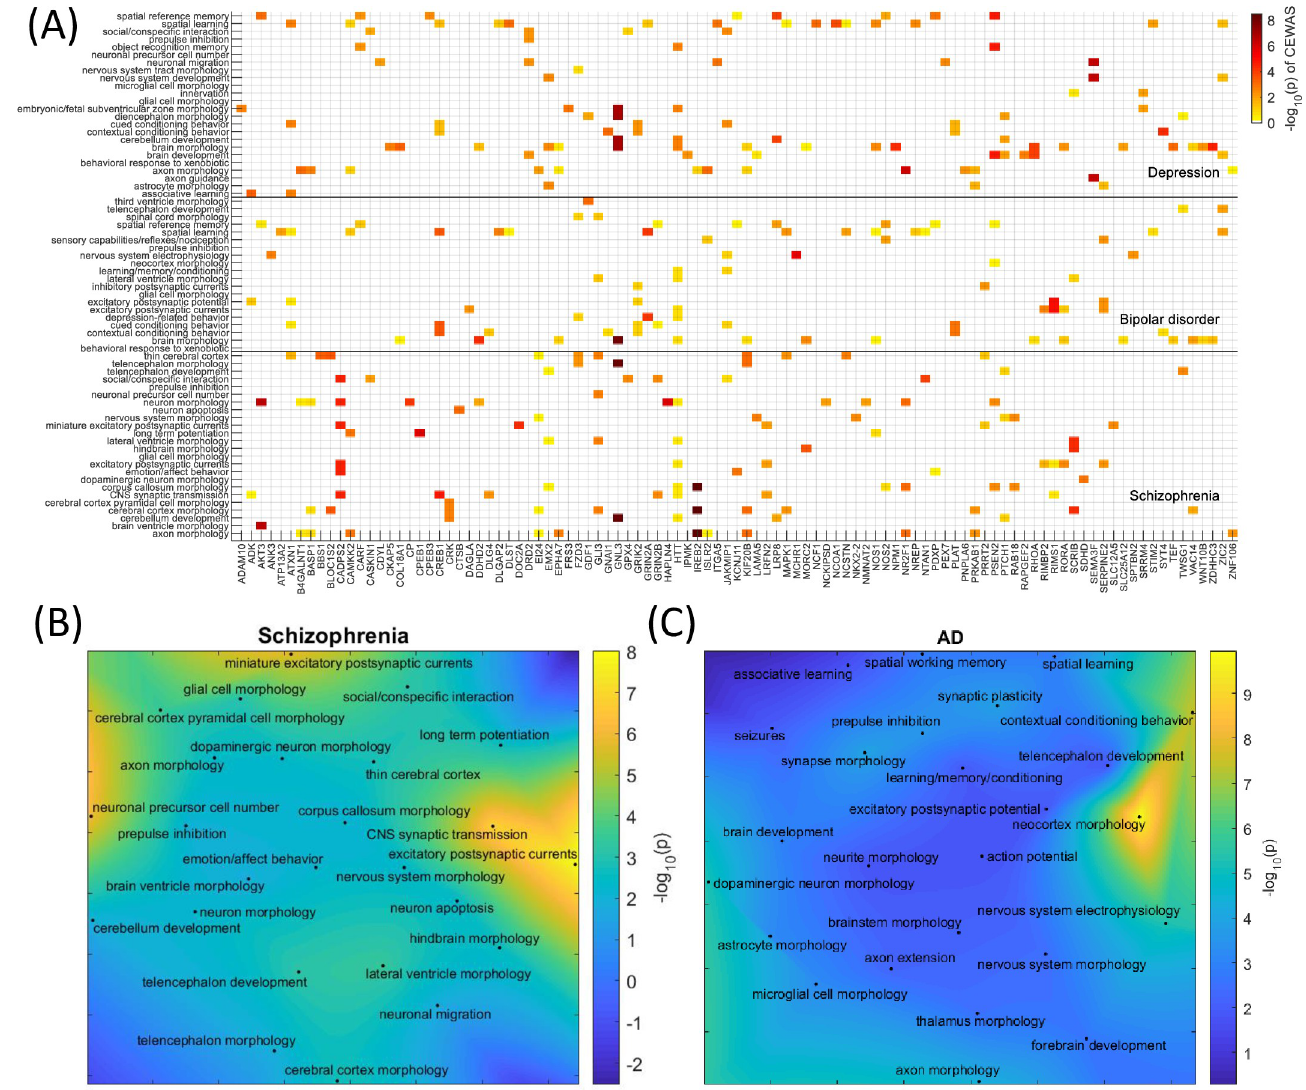
Fig 5. Gene set enrichment. (A) Top CNS gene sets enriched for schizophrenia, bipolar disorder, and depression as found by CEWAS displayed against genes belonging to at least one of these enriched gene sets and have CEWAS p < 0.05 in at least one of the three psychiatric disorders. The color reflects the level of association between a given gene and a disorder. For each gene set, only genes belonging to that gene set have their–log 10 (p) displayed, with the rest of the genes masked to zero. (B) Top 25 CNS gene sets enriched for schizophrenia as found by CEWAS displayed. The binary representation of the gene sets are projected onto 2D space using UMAP, and the colors indicate the level of gene set enrichment. (C) Top 25 CNS gene sets enriched for AD as found by CEWAS displayed in 2D UMAP space. https://doi.org/10.1371/journal.pgen.1009918.g005 PLOS Genetics | https://doi.org/10.1371/journal.pgen.1009918 November 22,